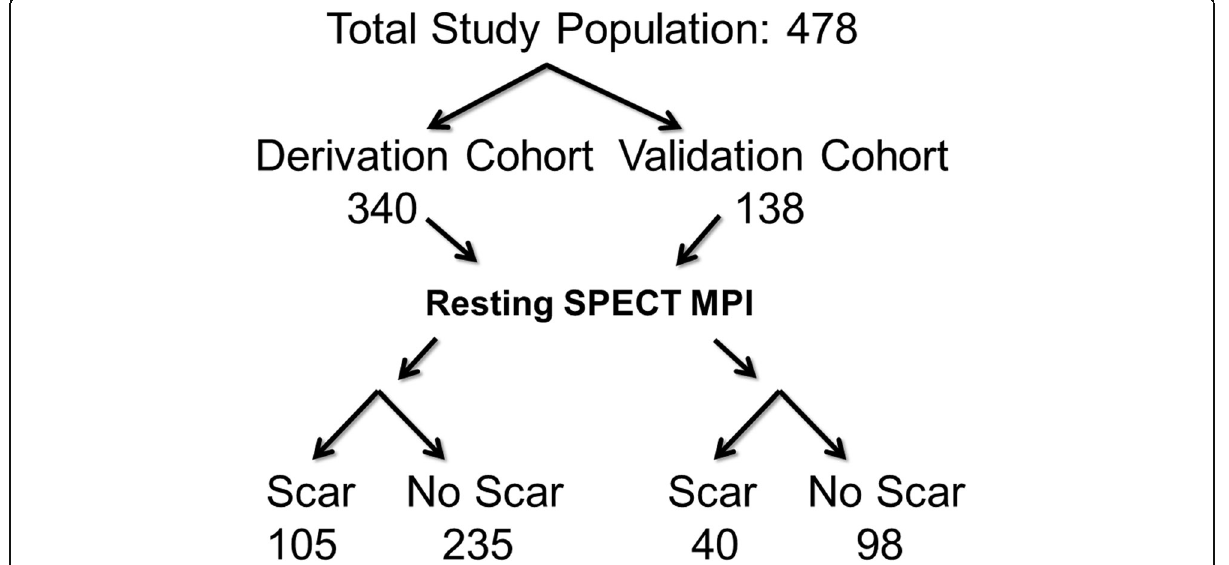
Fig. 1 Study design. The total study population was 478 patients. Patients enrolled between August 2014 and September 2015 were included in the training group. Patients enrolled from October 2015 to November 2016 were included in the validation group (138 total). Both groups underwent resting SPECT MPI and were subsequently classified as having a scar or not having a scar based upon their resting SPECT MPI interpretation. Abbreviations: MPI, myocardial perfusion imaging; SPECT, single-photon emission computed